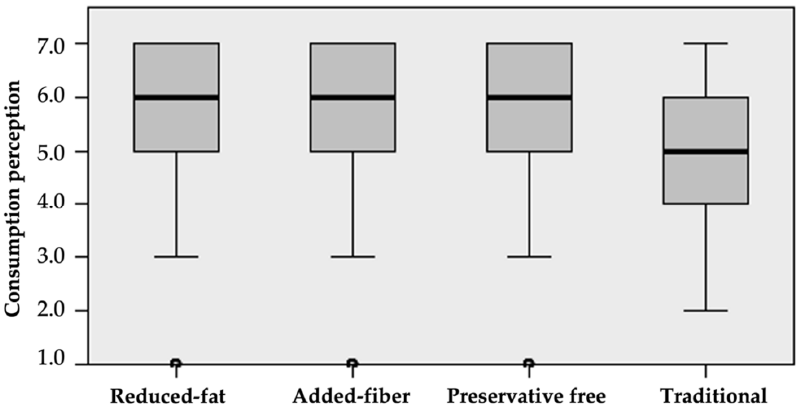
Figure 3. Median test for probability of meatball consumption.